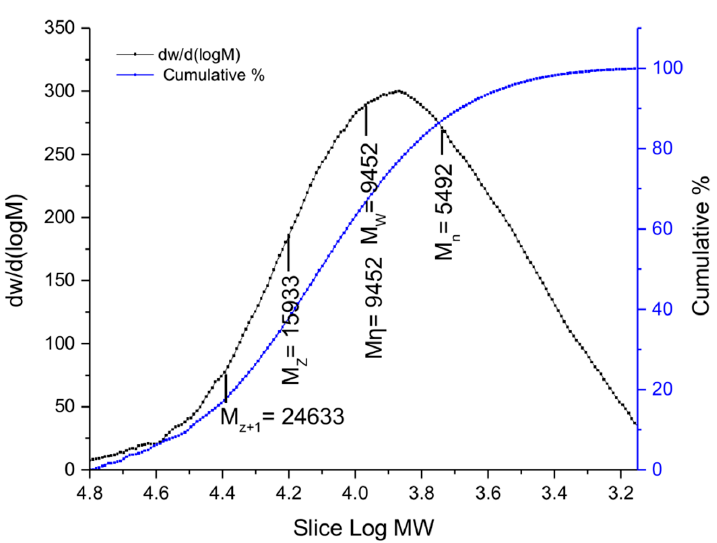
Figure 6. Molecular weight distribution curve for hydrogel (Nano-Al 2 O 3 -AD, 50 µL injected). Black line: differential curve; blue line: integral curve.